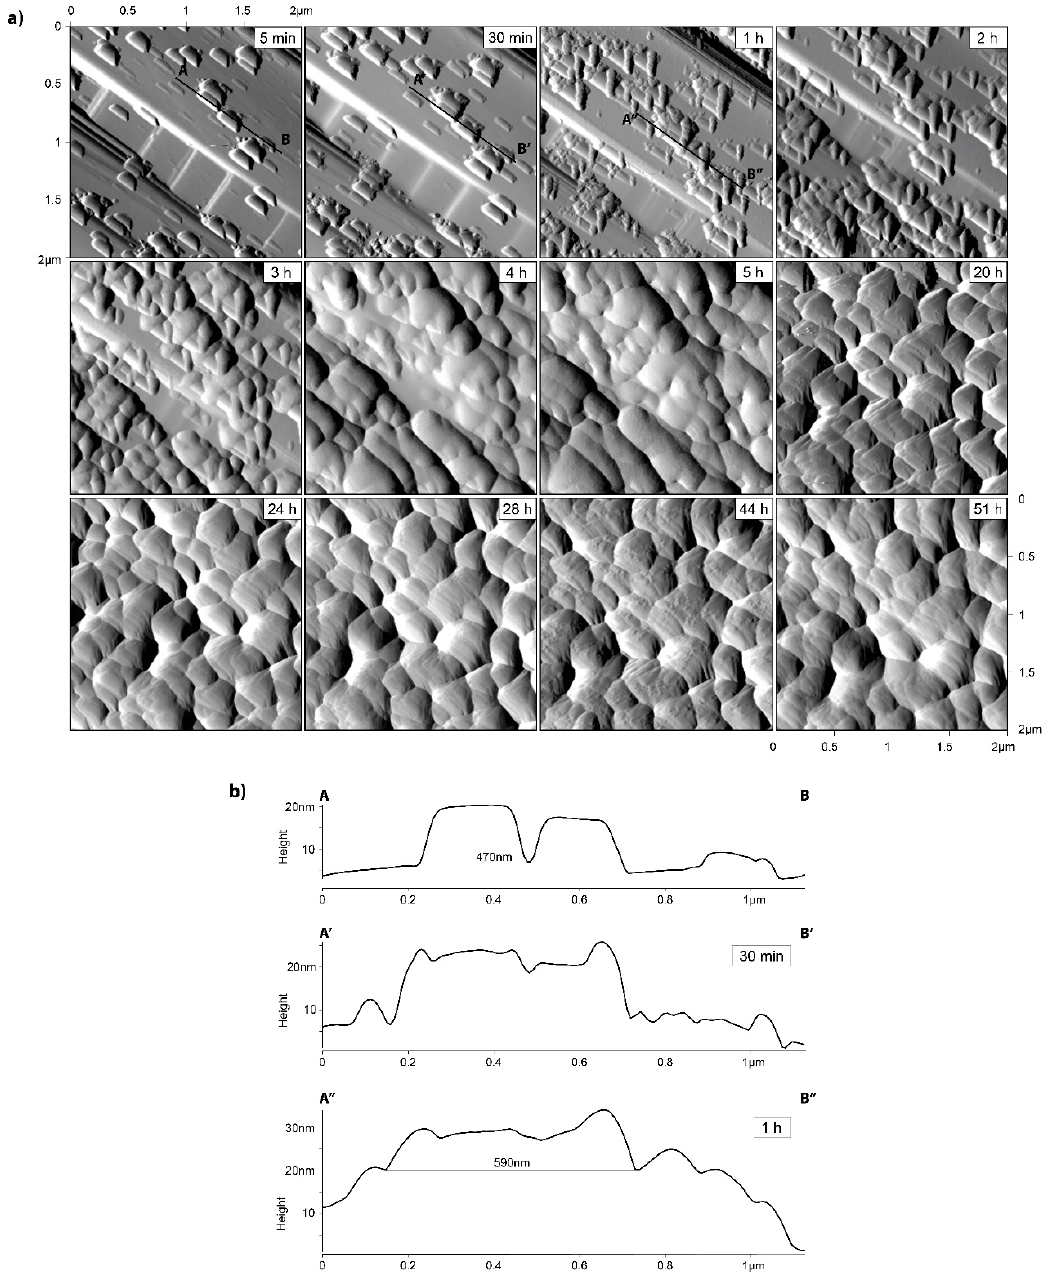
Figure 6. Sequence of amplitude retrace AFM images of the same surface area ( a ) and related sections ( b ) of offretite surface at 25 °C, at different time of interaction in Gamble’s solution (pH 8.17). A new growing phase on the surface is recognizable.